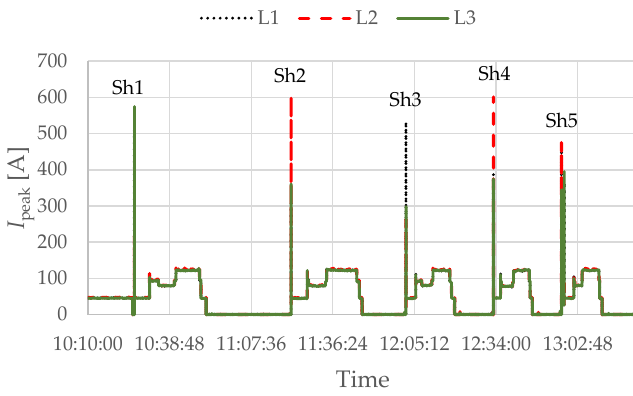
Figure 21. Peak currents in cores registered at Substation 1. Circuit 1 cable line.